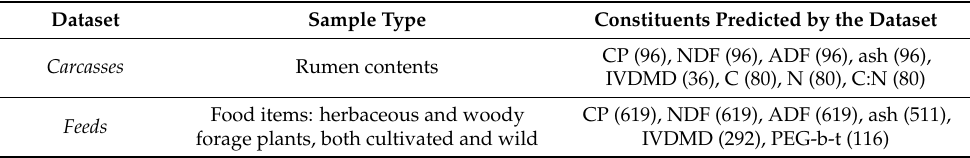
Table 3. Description of the two datasets used for NIRS-aided prediction of various constituents in gazelle rumen contents: crude protein (CP), neutral detergent fiber (NDF), acid detergent fiber (ADF), in vitro dry matter digestibility (IVDMD), Carbon (C), Nitrogen (N), and polyethylene glycol-binding tannins (PEG-b-t). The number of samples used for calibrating each constituent in parentheses.